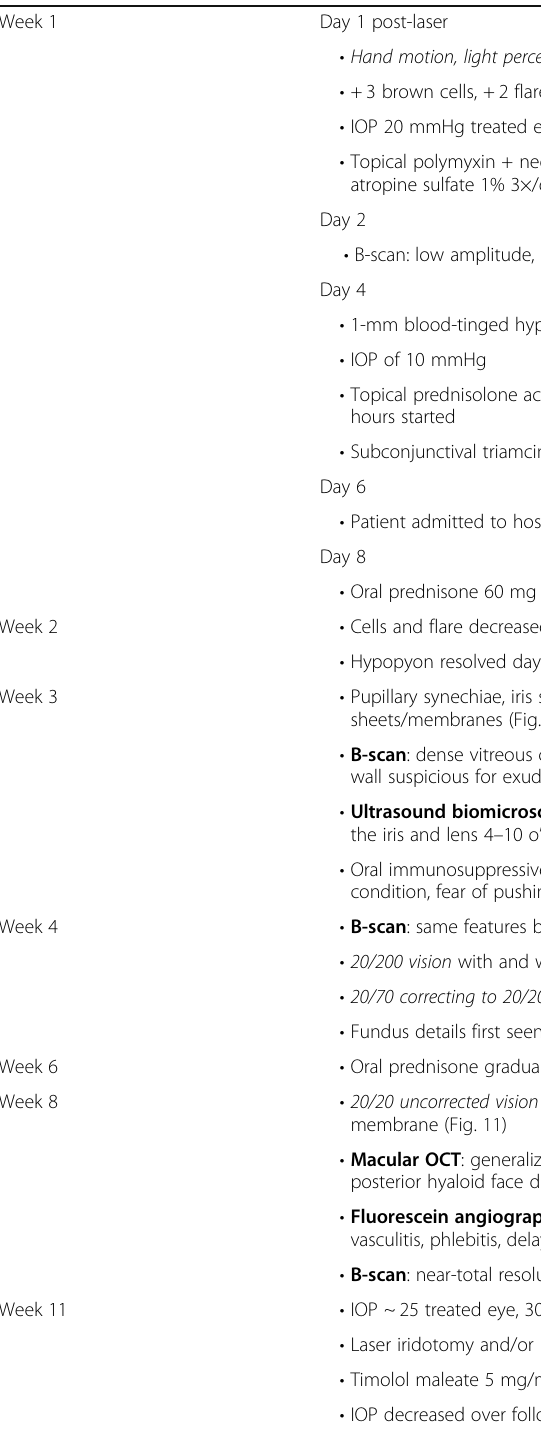
Table 1 Chronology of major